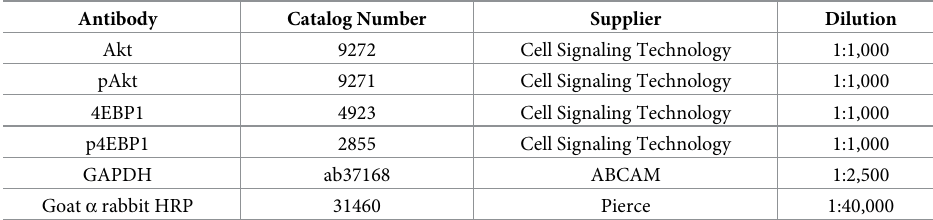
Table 1. Antibodies utilized for western